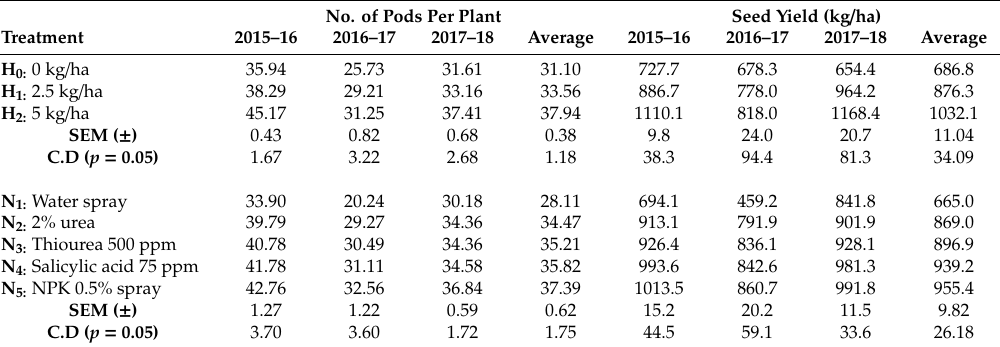
Table 2. Seed yield and number of pods per plant of lentil as influenced by di ff erent levels of hydrogel and foliar nutrition.